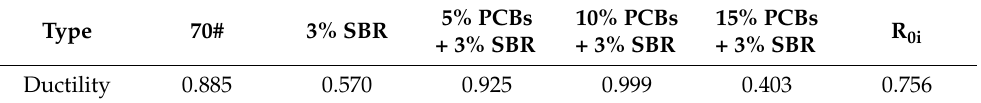
Table 11. Grey correlation between bitumen ductility and bending stiffness modulus of mixture. Type